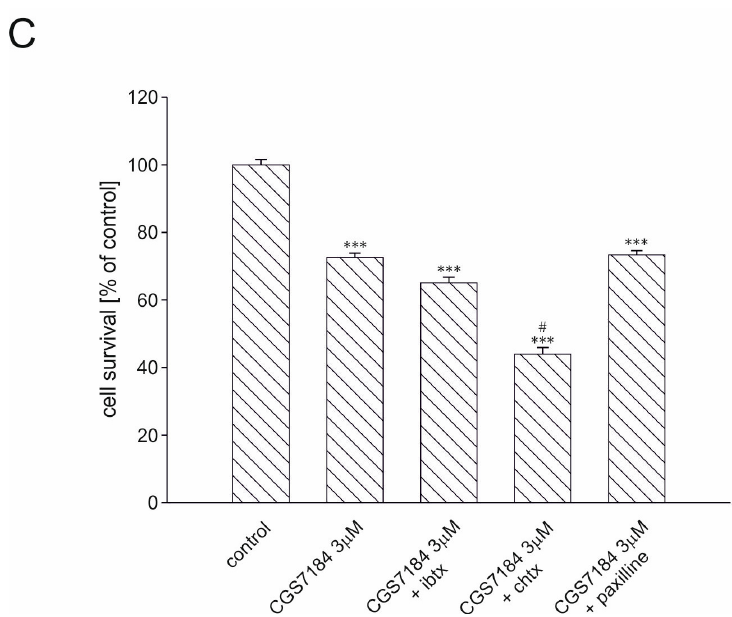
Figure 4. Dose and time dependence of toxic effects induced by CGS7181 and CGS7184. ( A ) HT22 cells were treated with potassium channel openers CGS7181 (diamonds) or CGS7184 (triangles). Cell survival was measured using the MTT assay 18 h after opener application. ( B ) HT22 cells were treated with the potassium channel opener CGS7184 at different concentrations: 30 µ M (diamonds), 10 µ M (circles), 3 µ M (triangles), and 0.3 µ M (squares). Cell survival was measured using the MTT assay 3, 6, 9, 12, and 18 h after opener application. ( C ) HT22 cells were treated with 3 µ M CGS7184 in the presence of chtx-charybdotoxin (500 nM), ibtx-iberiotoxin (100 nM), pax-paxilline (2 µ M). All data